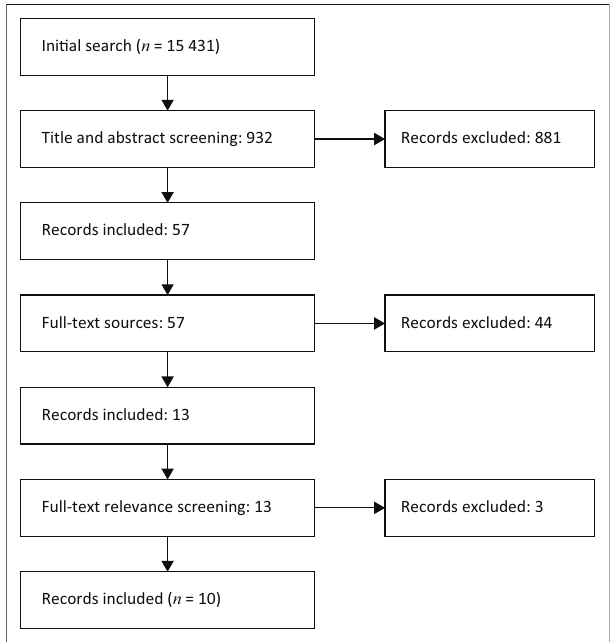
FIGURE 1: Summary of screening stages.